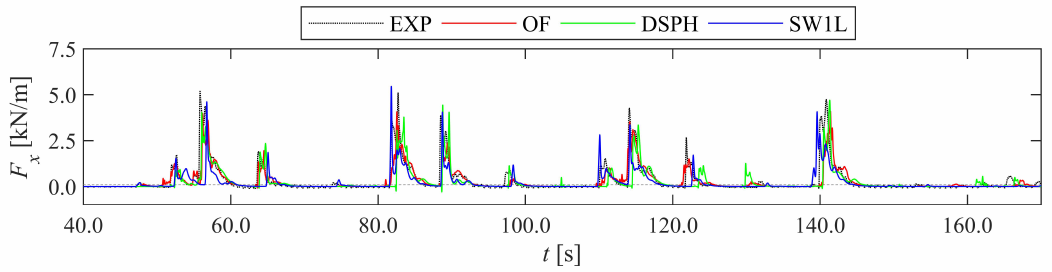
Figure 7. Comparison of the F x time series at the vertical wall. The experiment is the load cell force measurement. Adapted from the work in [3], with permission from the authors,